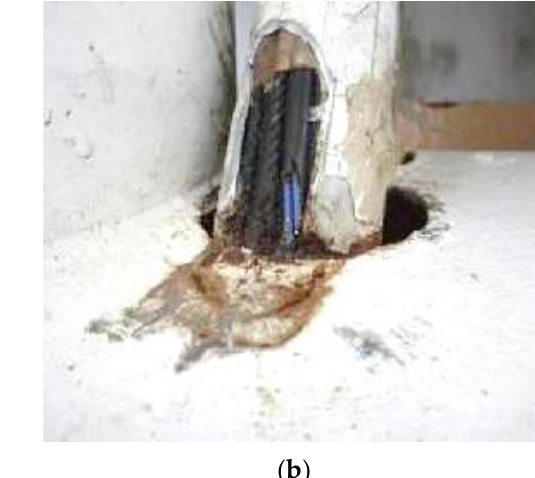
Figure 2. Damage to tie cables: ( a ) Steel wire abrasion of tie cable #11 and ( b ) damage of PE protec- tive sleeve of tie cable #12.